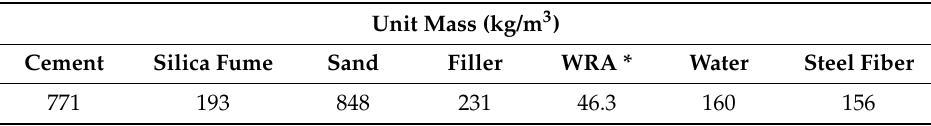
Table 2. Mix proportion of